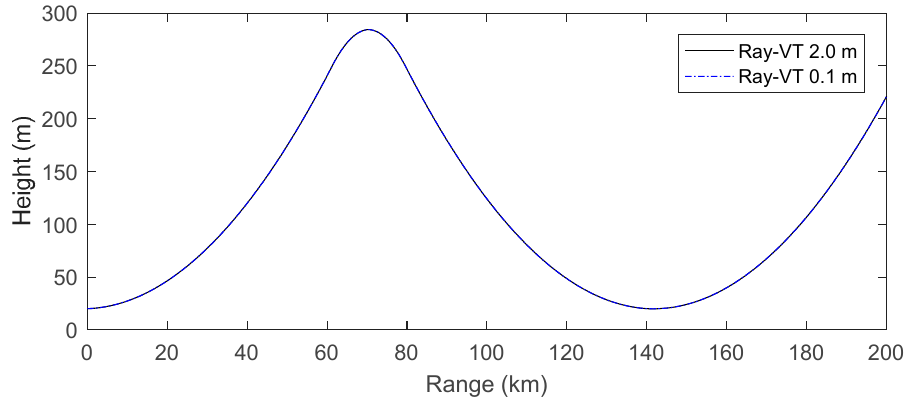
Figure 8. Comparison of the ray paths between the Ray-VT and Sevgi’s tool for the surface-based duct propagation with elevation angle of 0.01°.